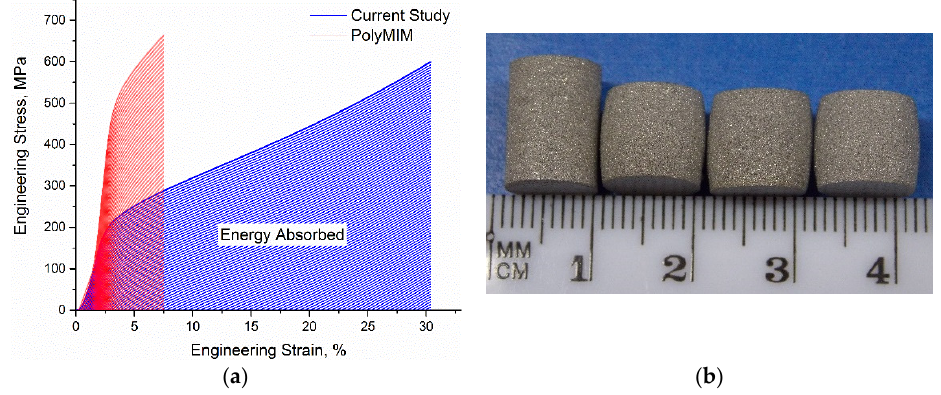
Figure 11. Results of the mechanical tests showing: ( a ) stress-strain curves of the sintered samples; ( b ) samples processed by the coarse powder after compression.